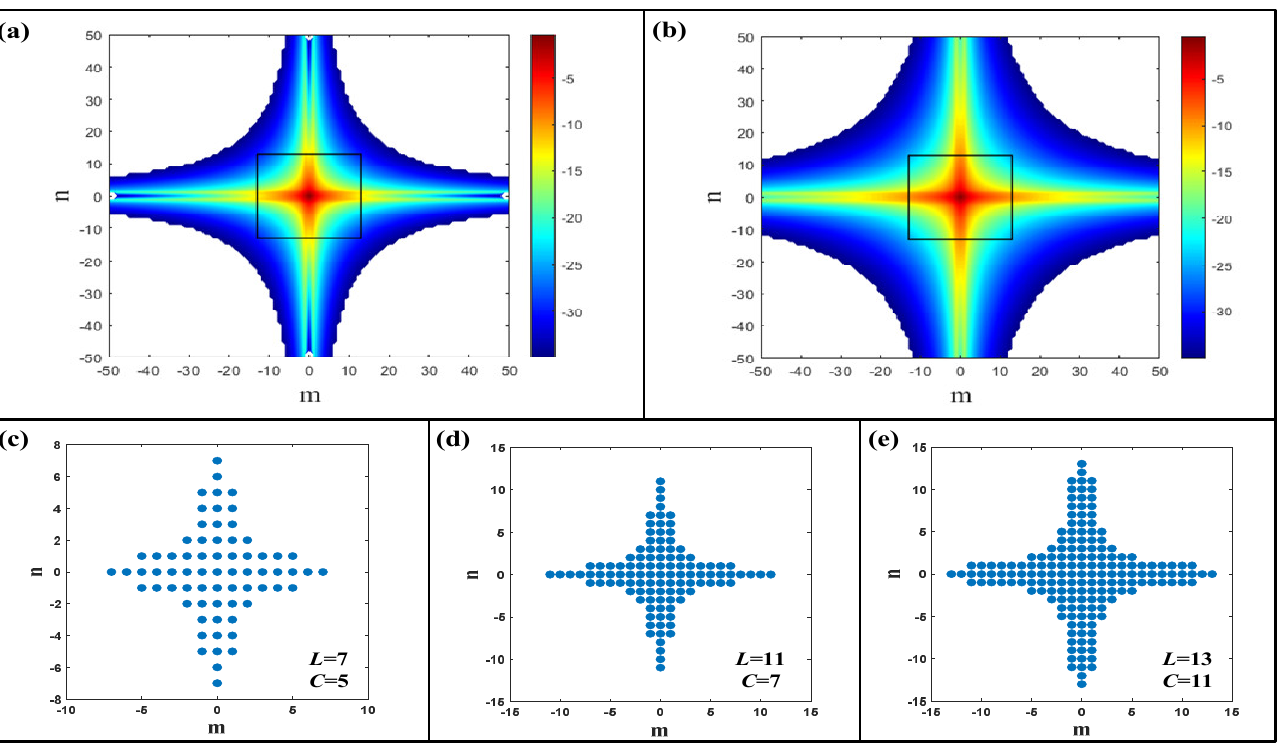
C for 28/85 GBaud PDM-16/64QAM af- , m n